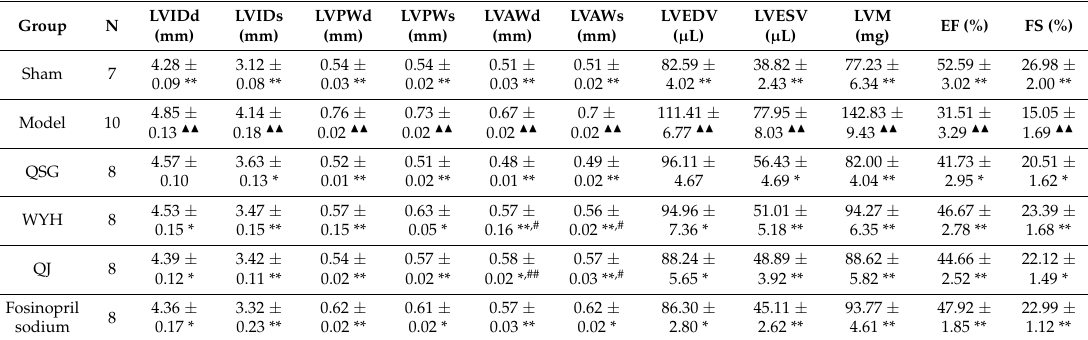
Table 1. Changes in cardiac ultrasound parameters after